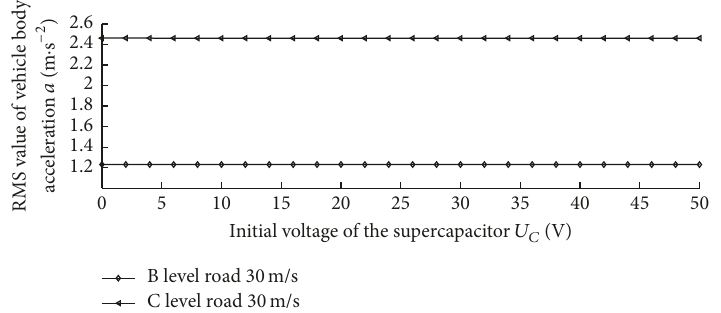
Figure 3: The relationship between vehicle body acceleration and supercapacitor initial terminal voltage.